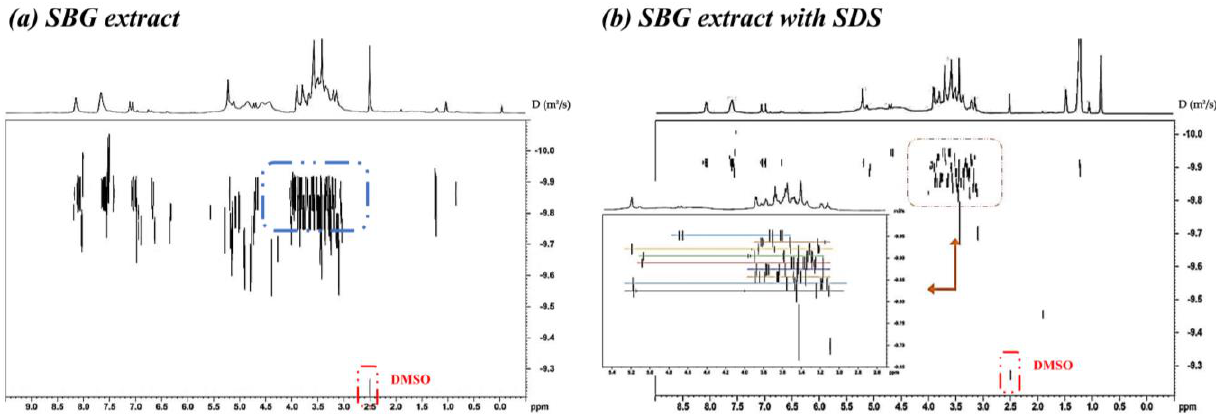
Figure 7. ( a ) DOSY spectra of S. baicalensis total flavonoid extract (25 mg) dissolved in 600 µ L DMSO– d 6 solution, ( b ) DOSY spectra of the same analytes after adding 10 mg SDS, and 1 H NMR signals of corresponding fractions were extracted. Table 2. Corresponding compounds and their search scores obtained by database retrieval of 9 1